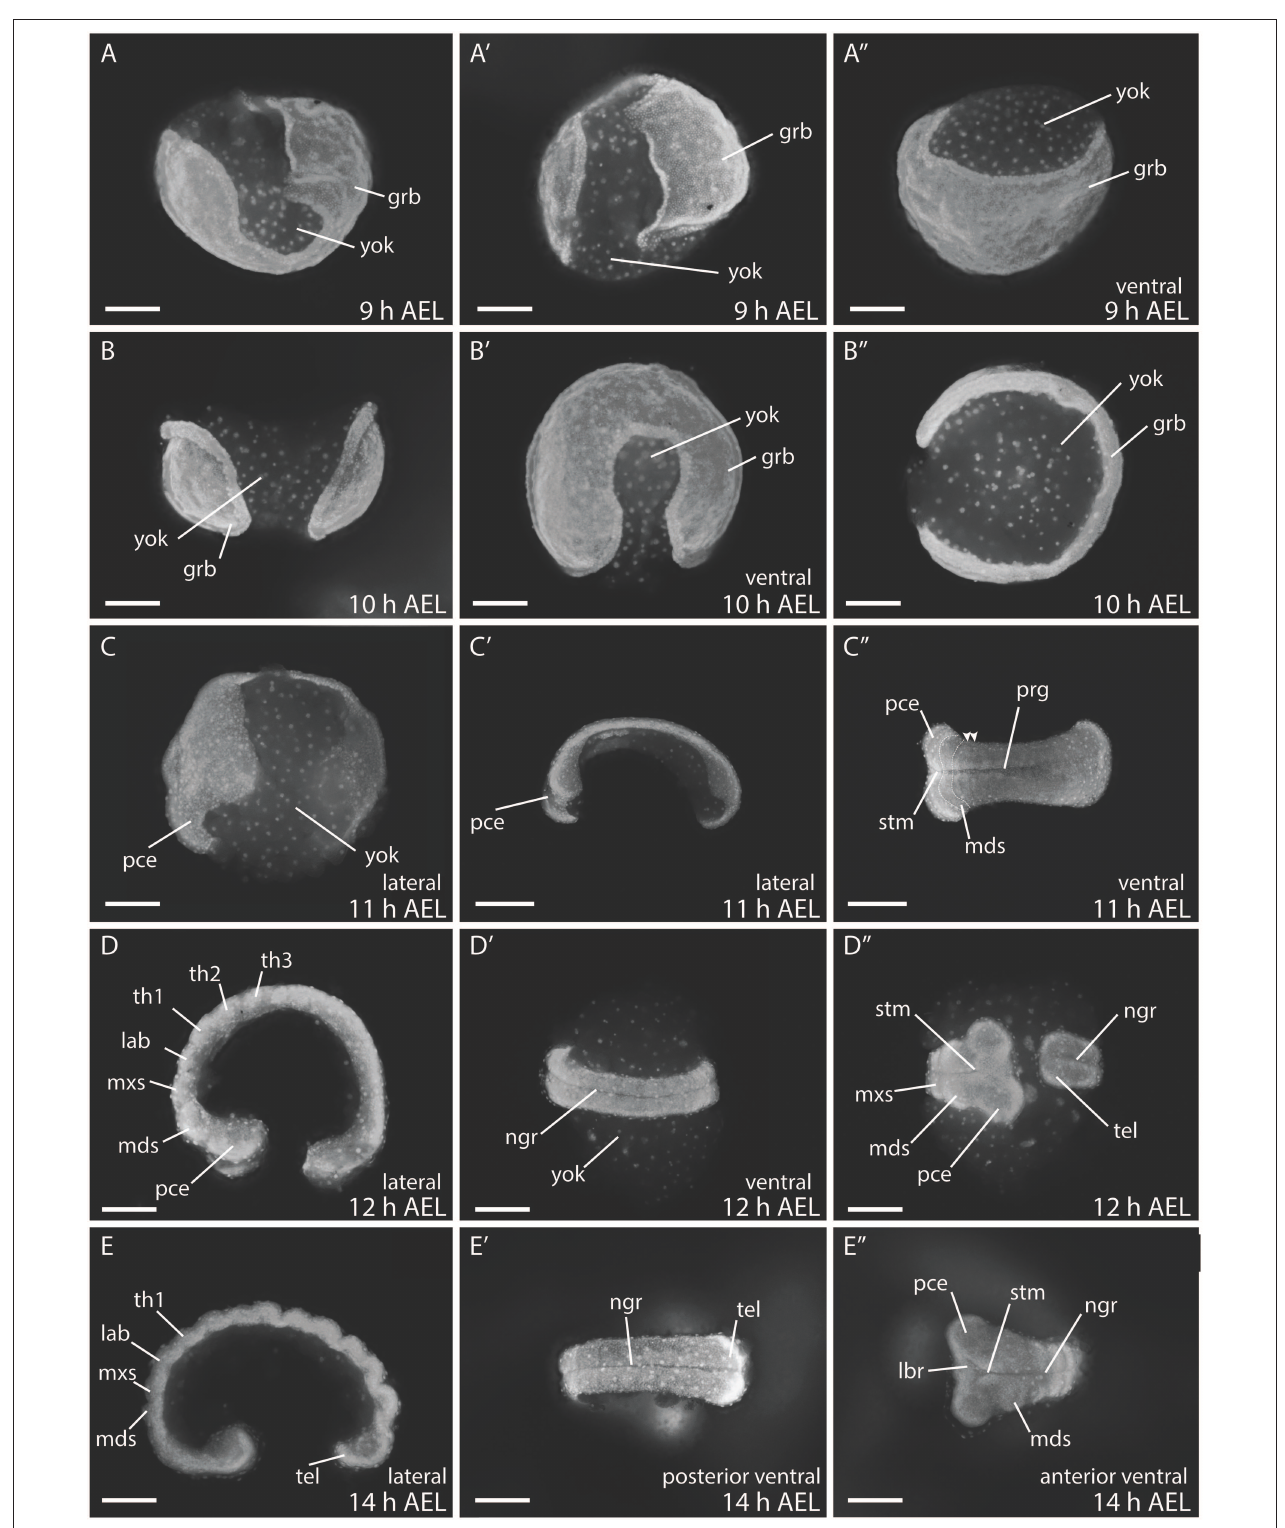
FIGURE 5 | Embryonic stages of B. anynana from 9 to 14h AEL. During this time the germ band develops into a basic patterned embryo with all gnathal, thoracic, and abdominal segments as well as the telson. (A–E ′′ ) See text for detailed description. AEL, after egg laying; grb, germ band; lab, labial segment; lbr, labrum; mds, mandibular segment; mxs, maxillary segment; ngr, neurogenic furrow; pce, protocephalon; pco, protocorm; prg, primitive grove; stm, stomodeum; tel, telson; th1-3, thoracic segment 1-3; yok, yolk. Orientation of embryos is indicated with anterior always to the left. Scale bar: 400 µ m.